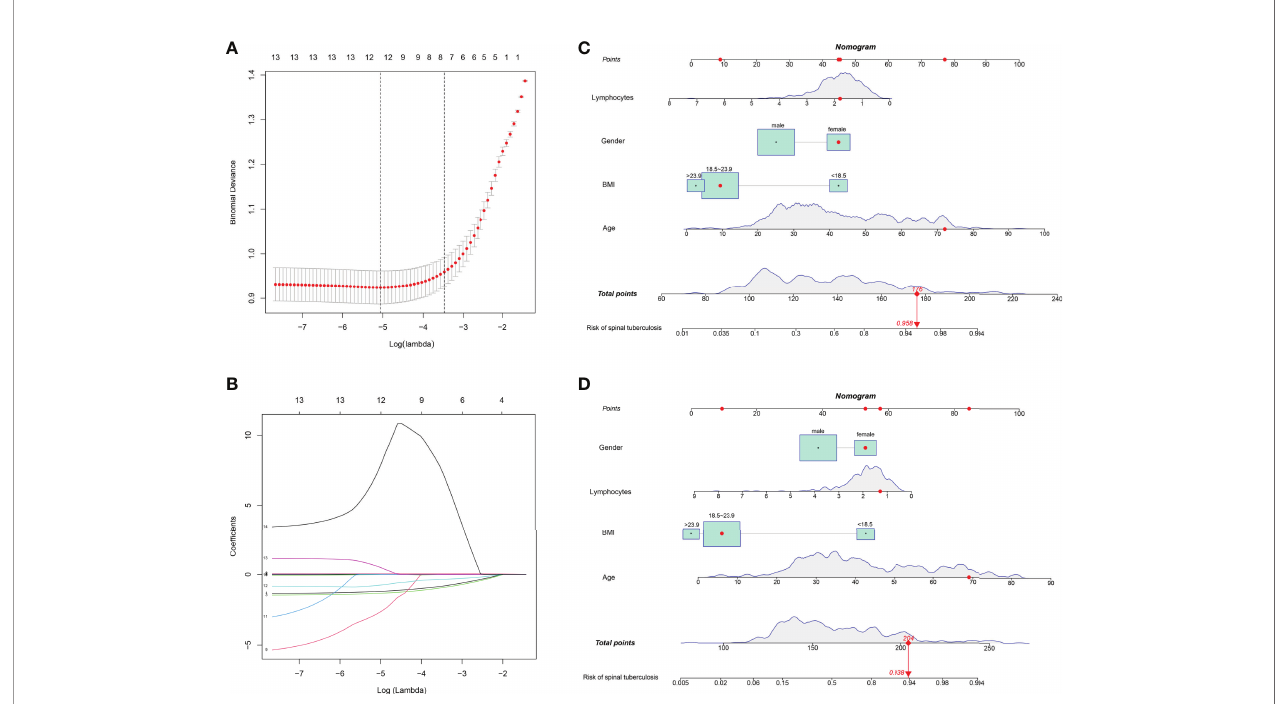
FIGURE 3 | Parameters were selected to build LASSO regression and nomogram models. (A) The binomial deviation was plotted through the optimal log (Lambda) value. (B) 12 non-zero coef fi cient parameters are screened by the optimal log (Lambda) value. (C) The nomogram predicting the risk of spinal tuberculosis was plotted in the training set. (D) The nomogram predicting the risk of spinal tuberculosis was plotted in the external validation set.